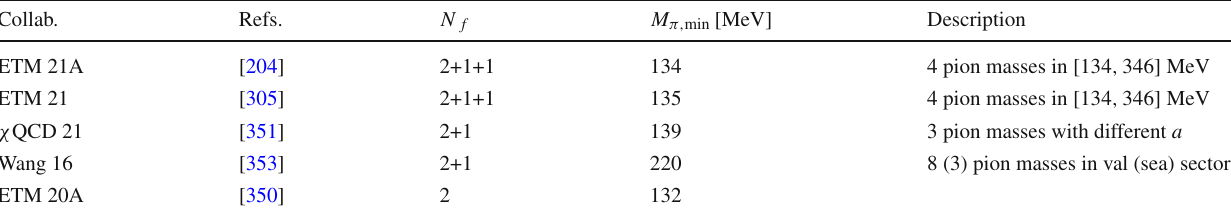
Table 113 Chiral extrapolation/minimum pion mass in determinations of the SU ( 2 ) low-energy constants (cid:13), F , ¯ (cid:6) 4 , ¯ (cid:6) 6 , and SU ( 3 ) low-energy constants (cid:13) 0 , F 0 Collab.